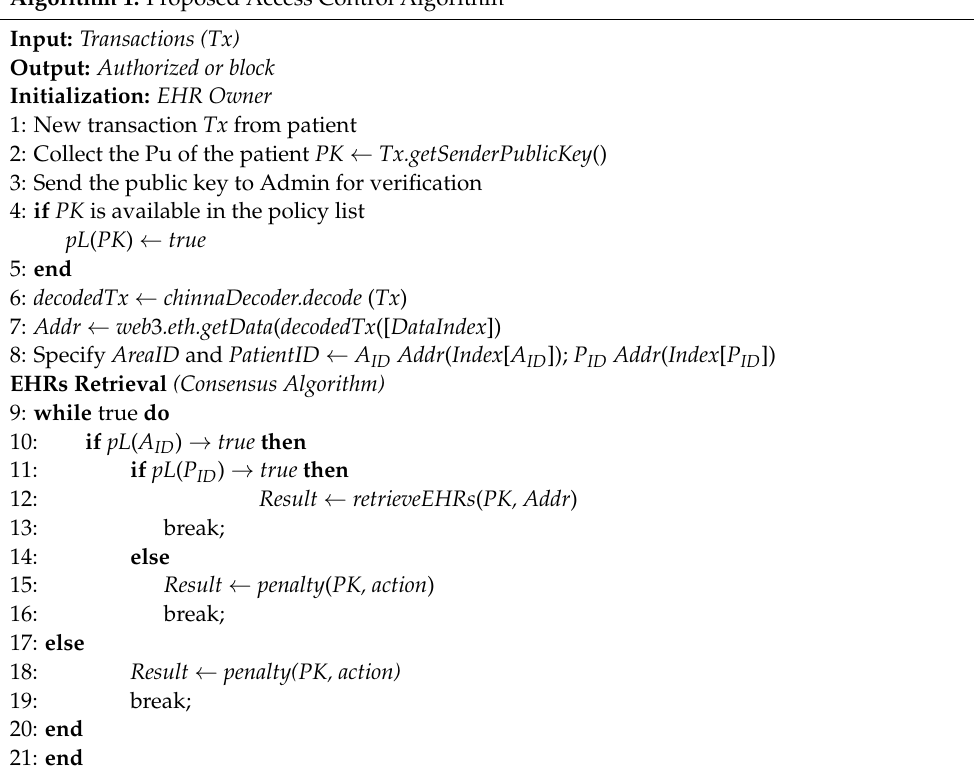
Algorithm 1. Proposed Access Control